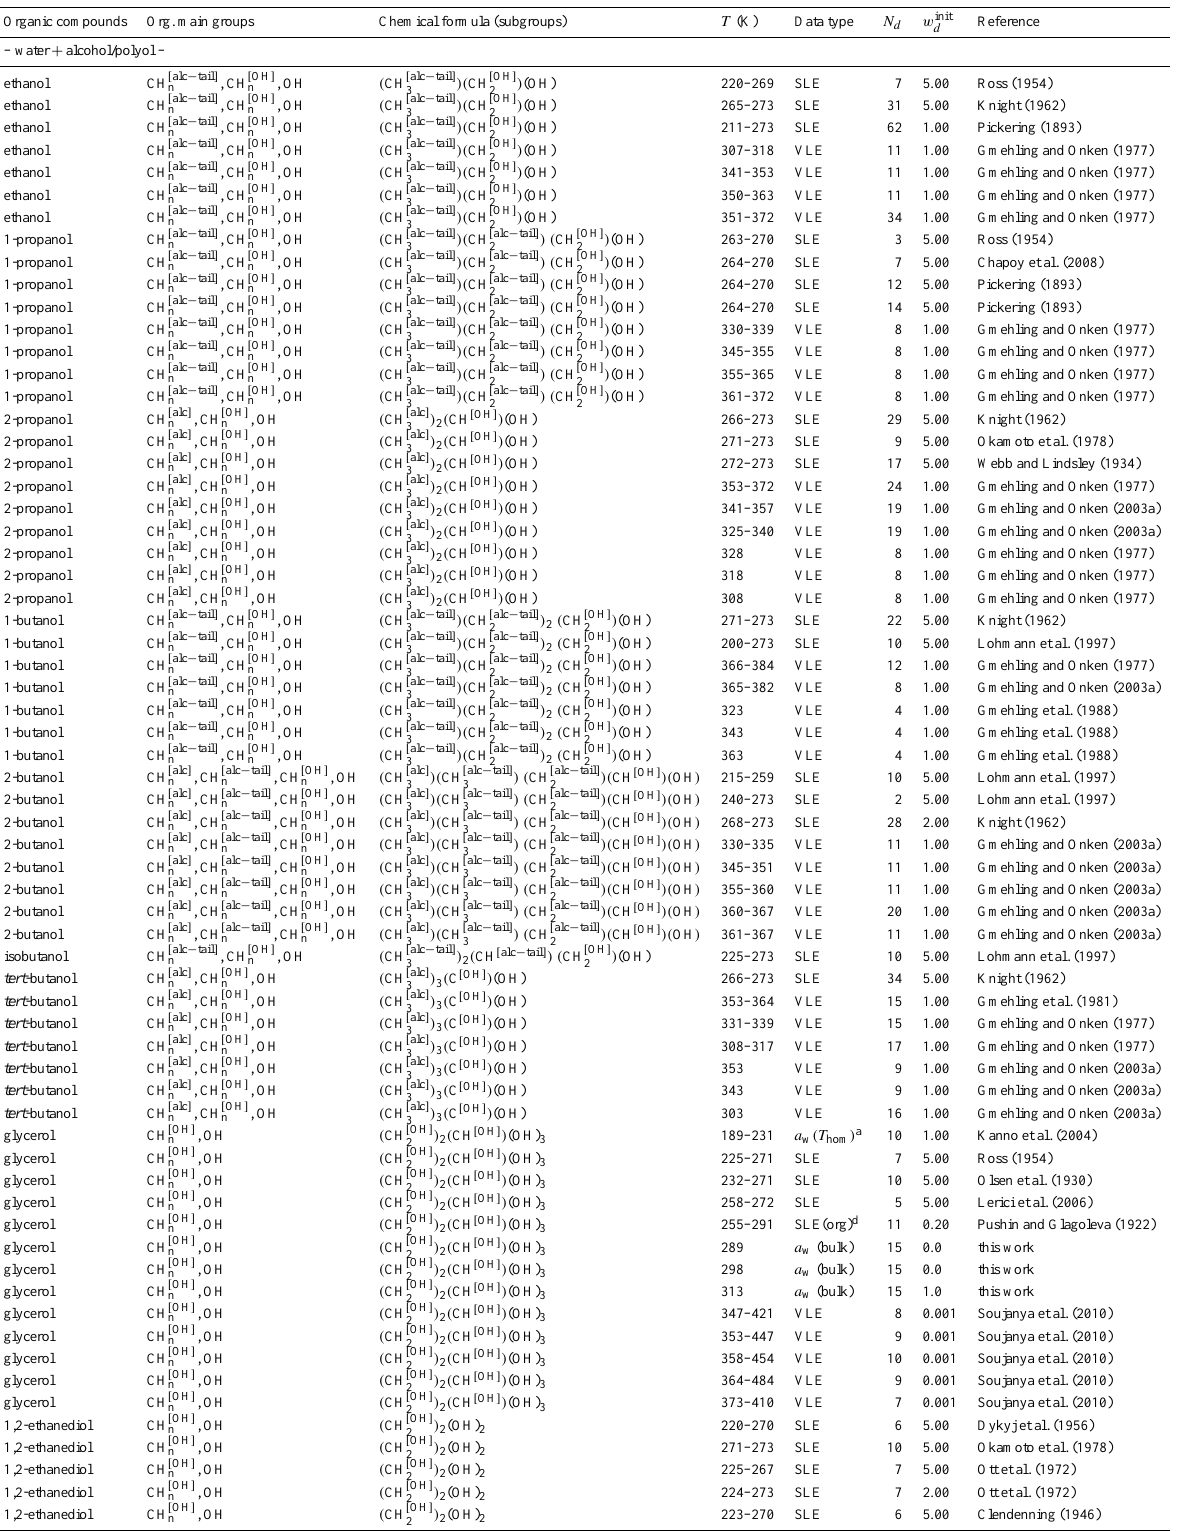
Table 1. Components, main groups, temperature range, number of data points ( N d ), initial weighting ( w init ter + organic” and “organic + organic” data sets used (where w init and organic ↔ organic main group